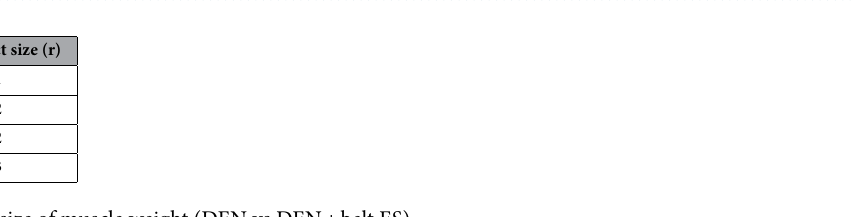
Table 1. Effect size of muscle weight (DEN vs DEN + belt